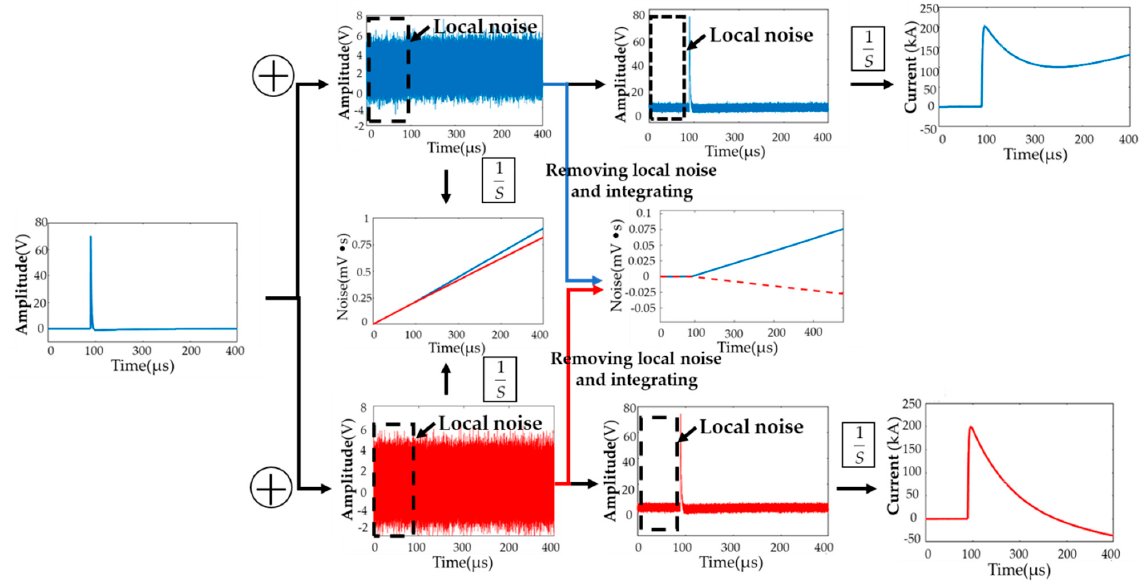
Figure 7. The integrated result of the original signal with different noise signals added after filtering out the local mean shows random updrift and droop effects.